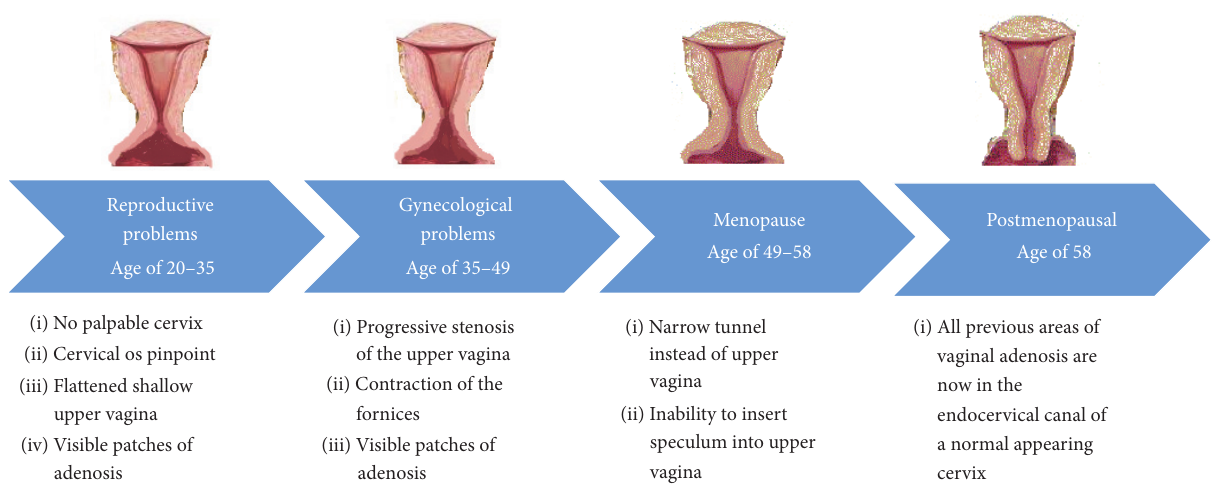
Figure 2: Timeline for Case 1 with schematic diagram showing the authors’ impression of progressive contraction of upper vagina with involution of vaginal adenosis into a new cervix.